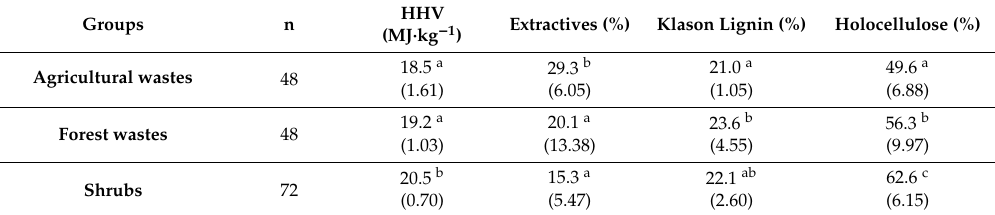
Table 2. Mean, SD in brackets, test comparison of means of HHV and chemical composition by biomass group. Note: mean values with the same letter are not significantly di ff erent for p < 0.05 by Duncan New Multiple Range test HHV–Higher Heating Value; n = number of samples used in each